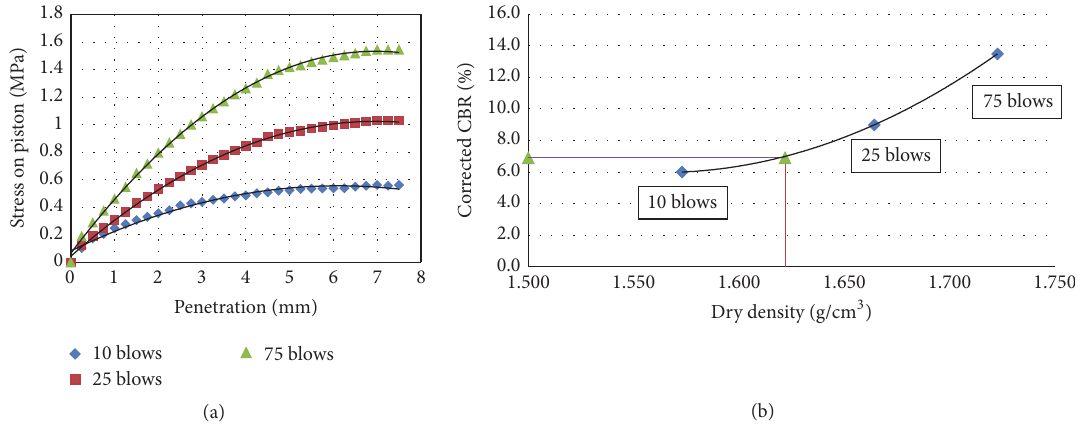
Figure 7: (a) Relationship between resistance and penetration for soil without additives. (b) CBR value for soil without additives.